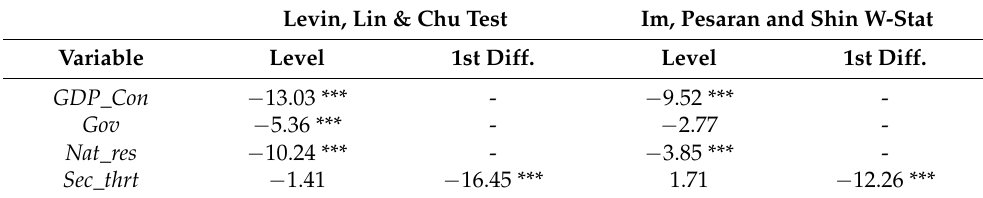
Table 2. Unit Root